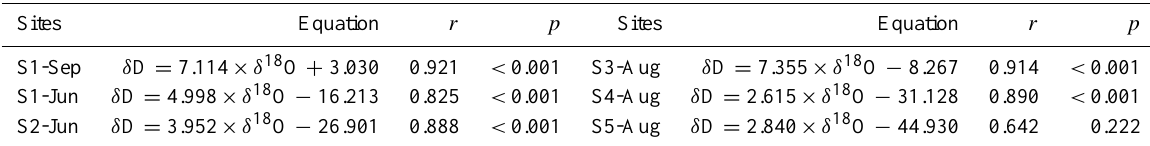
Table 9. Equations of soil water δ D and δ 18 O at each site using the linear least squares fit method. Here, r is the correlation coefficient, and p is the significance level. p < 0.001 indicates statistical significance at the 99.9% significance level, and p < 0.05 indicates statistical significance at the 95% significance